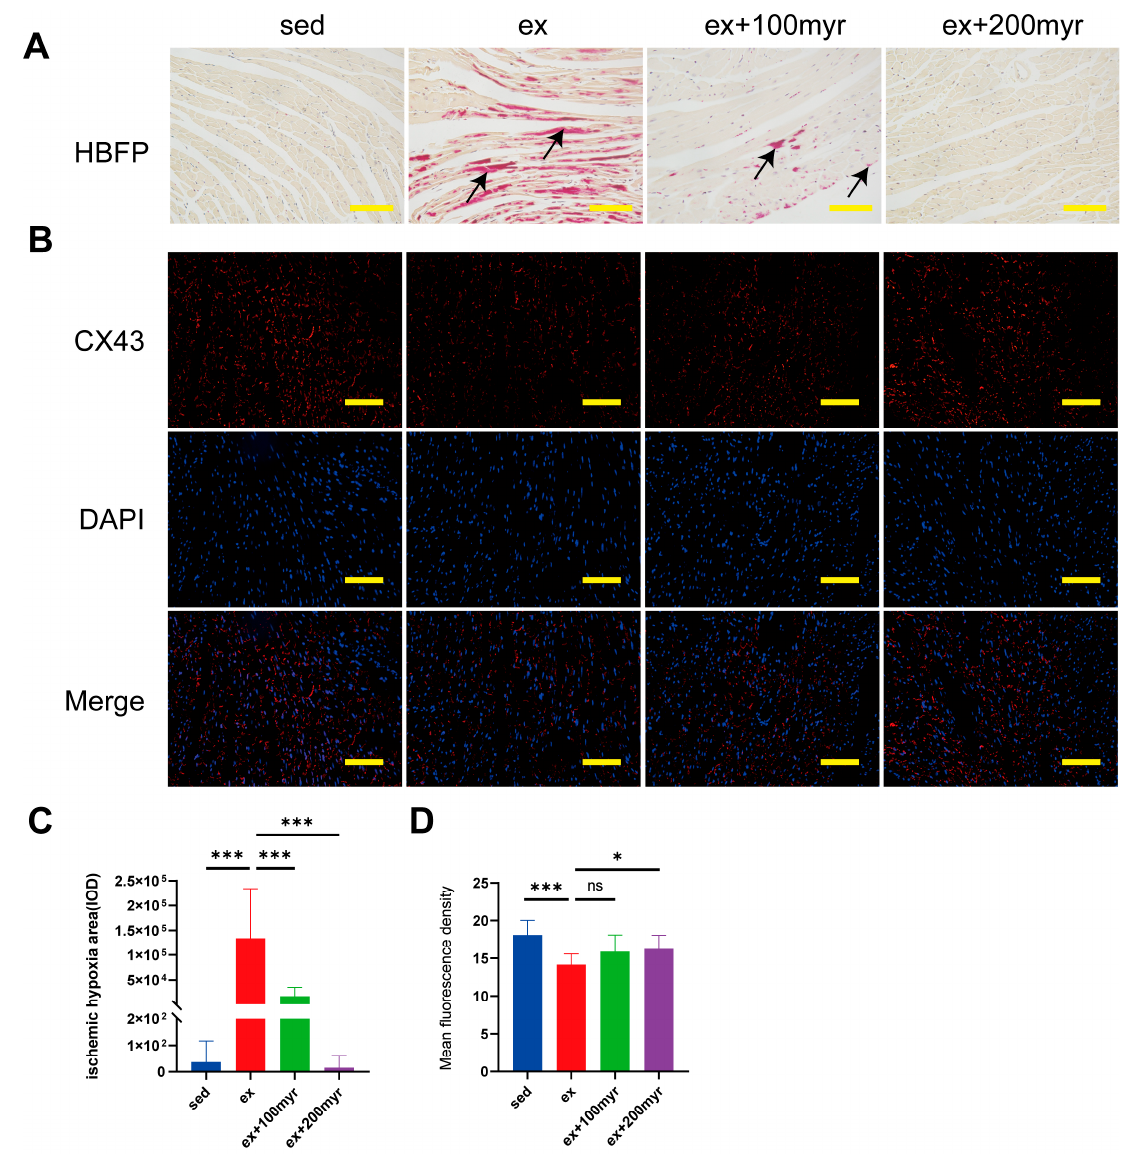
Figure 3. Effect of myricetin on the myocardial ischemic-hypoxic area and CX43 protein content. ( A ) Representative hematoxylin basic magenta picrate (HBFP) staining results. The red-stained area is the ischemic-hypoxic myocardium, and the yellow area is the normal myocardium; ( B ) representative immunofluorescence staining results. CX43 shows red fluorescence, and the nucleus shows blue fluorescence; ( C ) myocardial ischemic-hypoxic area; and ( D ) CX43 mean fluorescence density. Black arrows indicate ischemic-hypoxic myocardium. The data are presented as mean ± SD. * p < 0.05, *** p < 0.001, and ns represents no statistical difference; scale bar = 100 μ m.